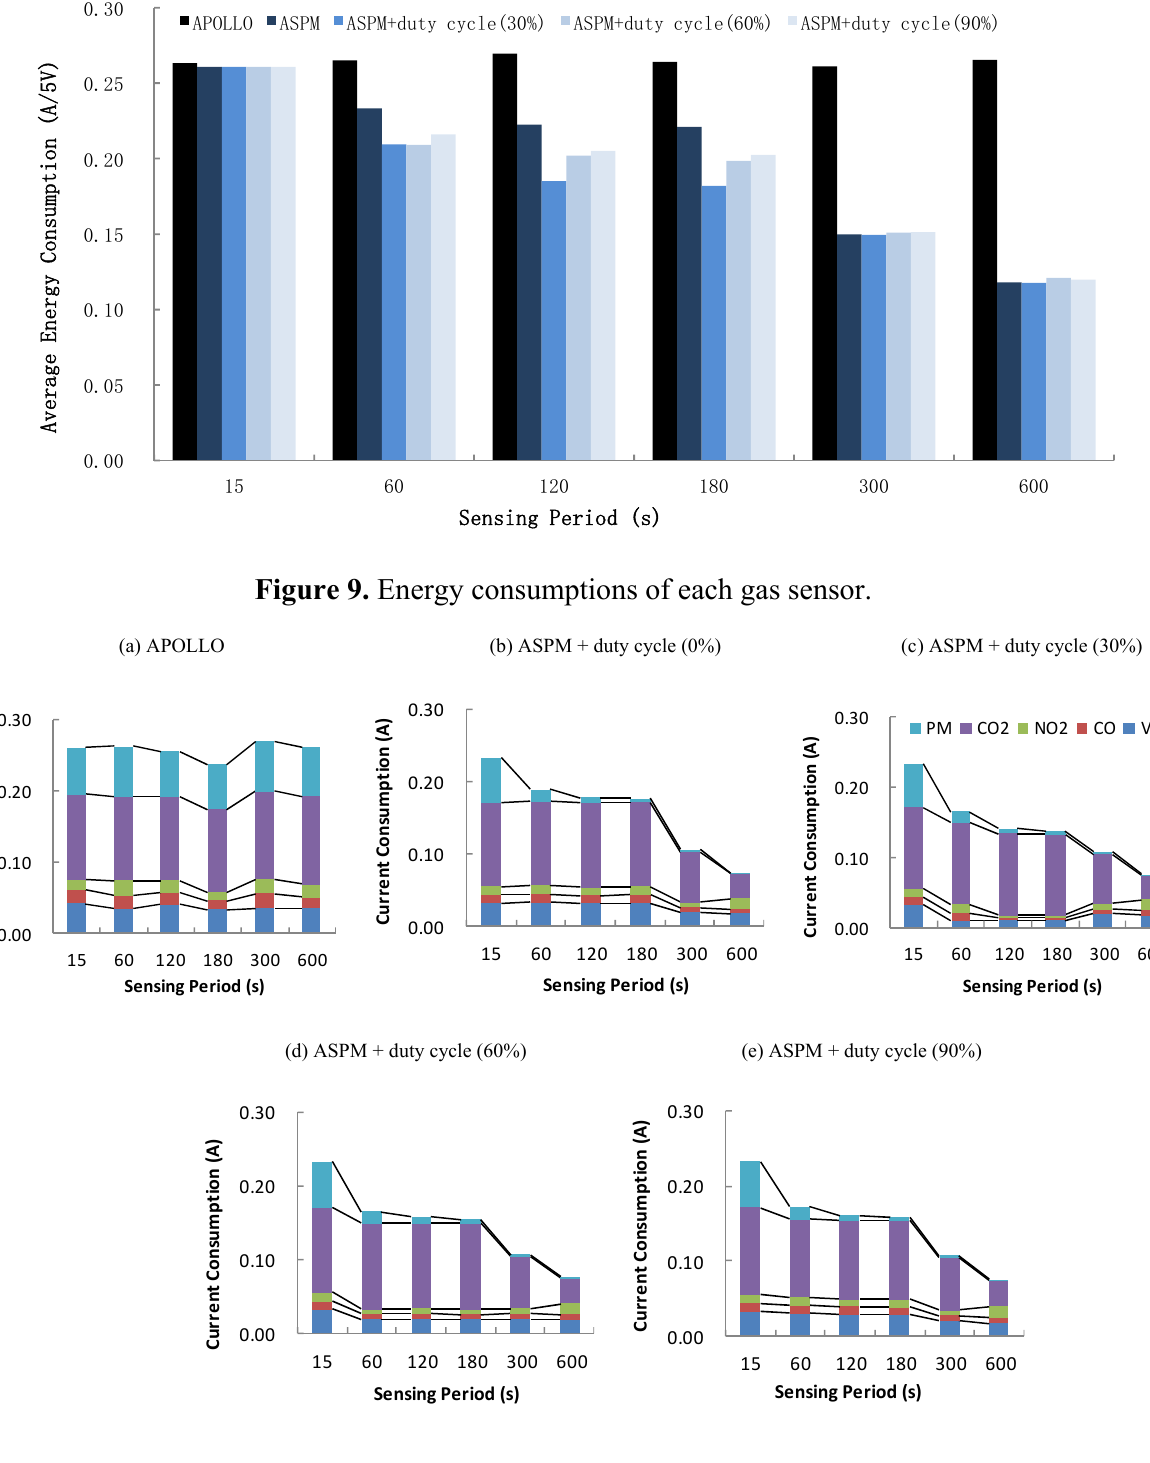
Figure 8. Average energy consumption.